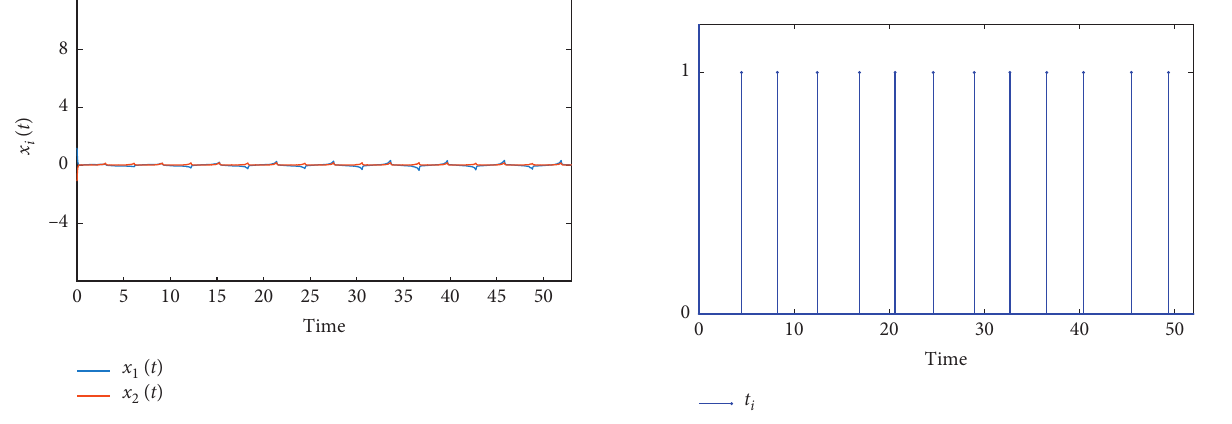
( i � 1 , 2 ) of system (112) under the i